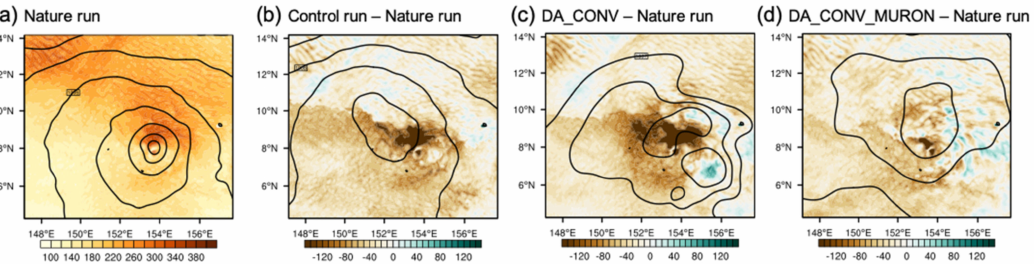
Figure 9. Surface latent heat flux [W m − 2 ] for ( a ) the nature run, and differences between the nature run and ( b ) the control run, ( c ) the DA_CONV analysis, and ( d ) the DA_CONV_MURON analysis valid at 1800 UTC 3 November 2013. The solid line denotes the sea level pressure